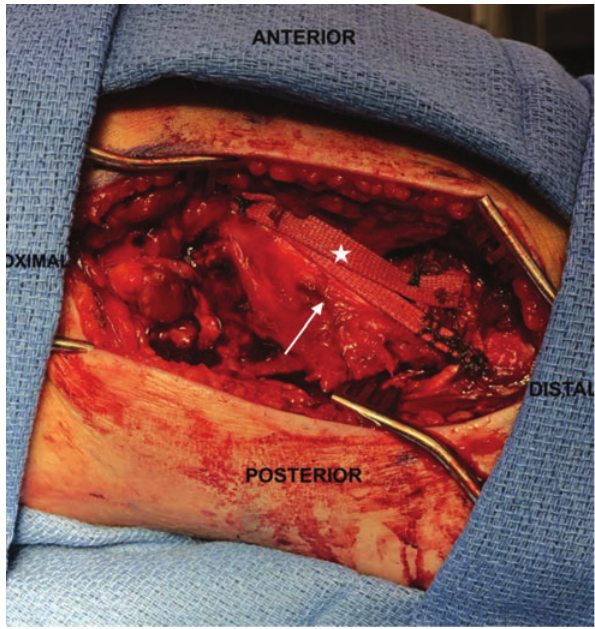
Primary left knee MCL repair (arrow) with overlying Fig. 3: Artelon augmentation (star), fixed with suture anchors.